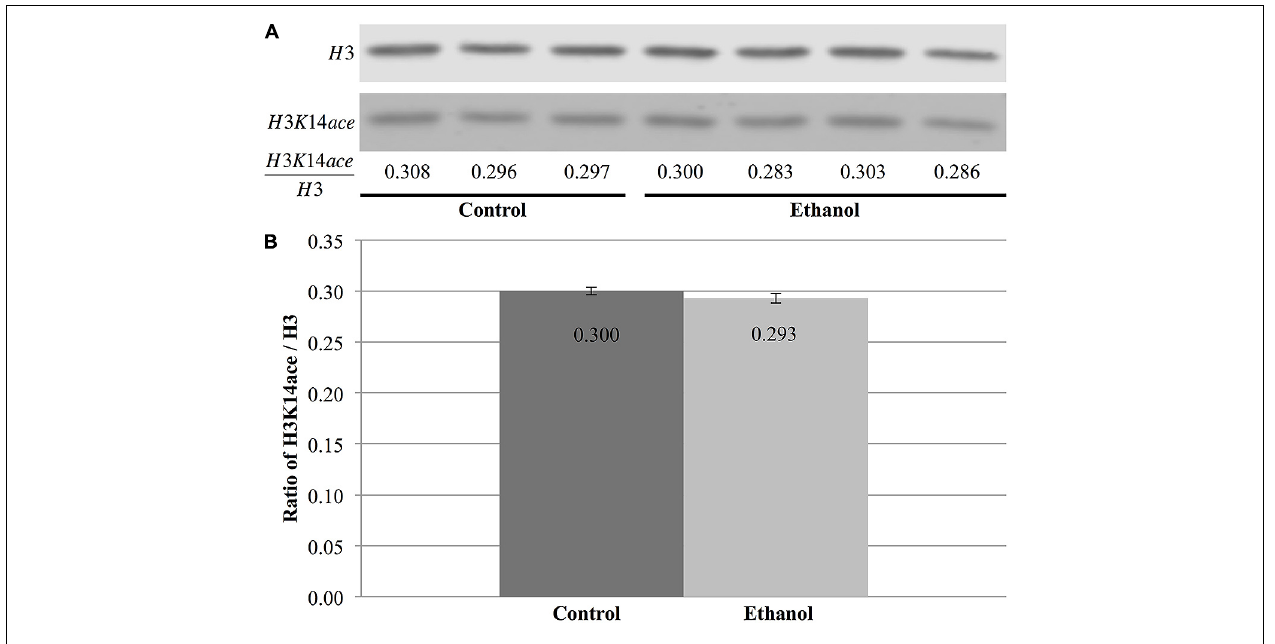
FIGURE 7 | Ethanol exposure does not affect levels of H3K14 acetylation in the cerebral cortex. (A) Protein blot analysis was performed on nuclear histones isolated from the cerebral cortex of three control and four ethanol male P7 mice.Total H3 levels were used as a loading control to normalize